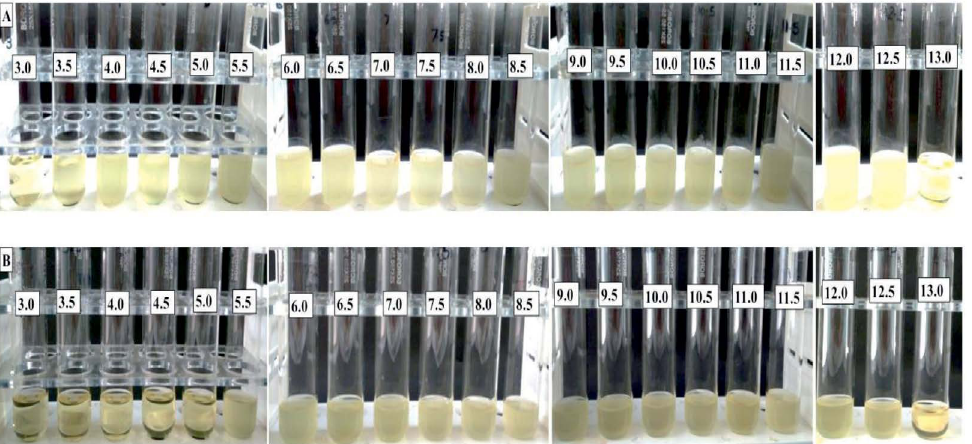
Fig. 1. Growth of A. T-2 isolate and B. MA-4 isolate on LB broth prepared in buffers of different pH range (3.0-13.0)